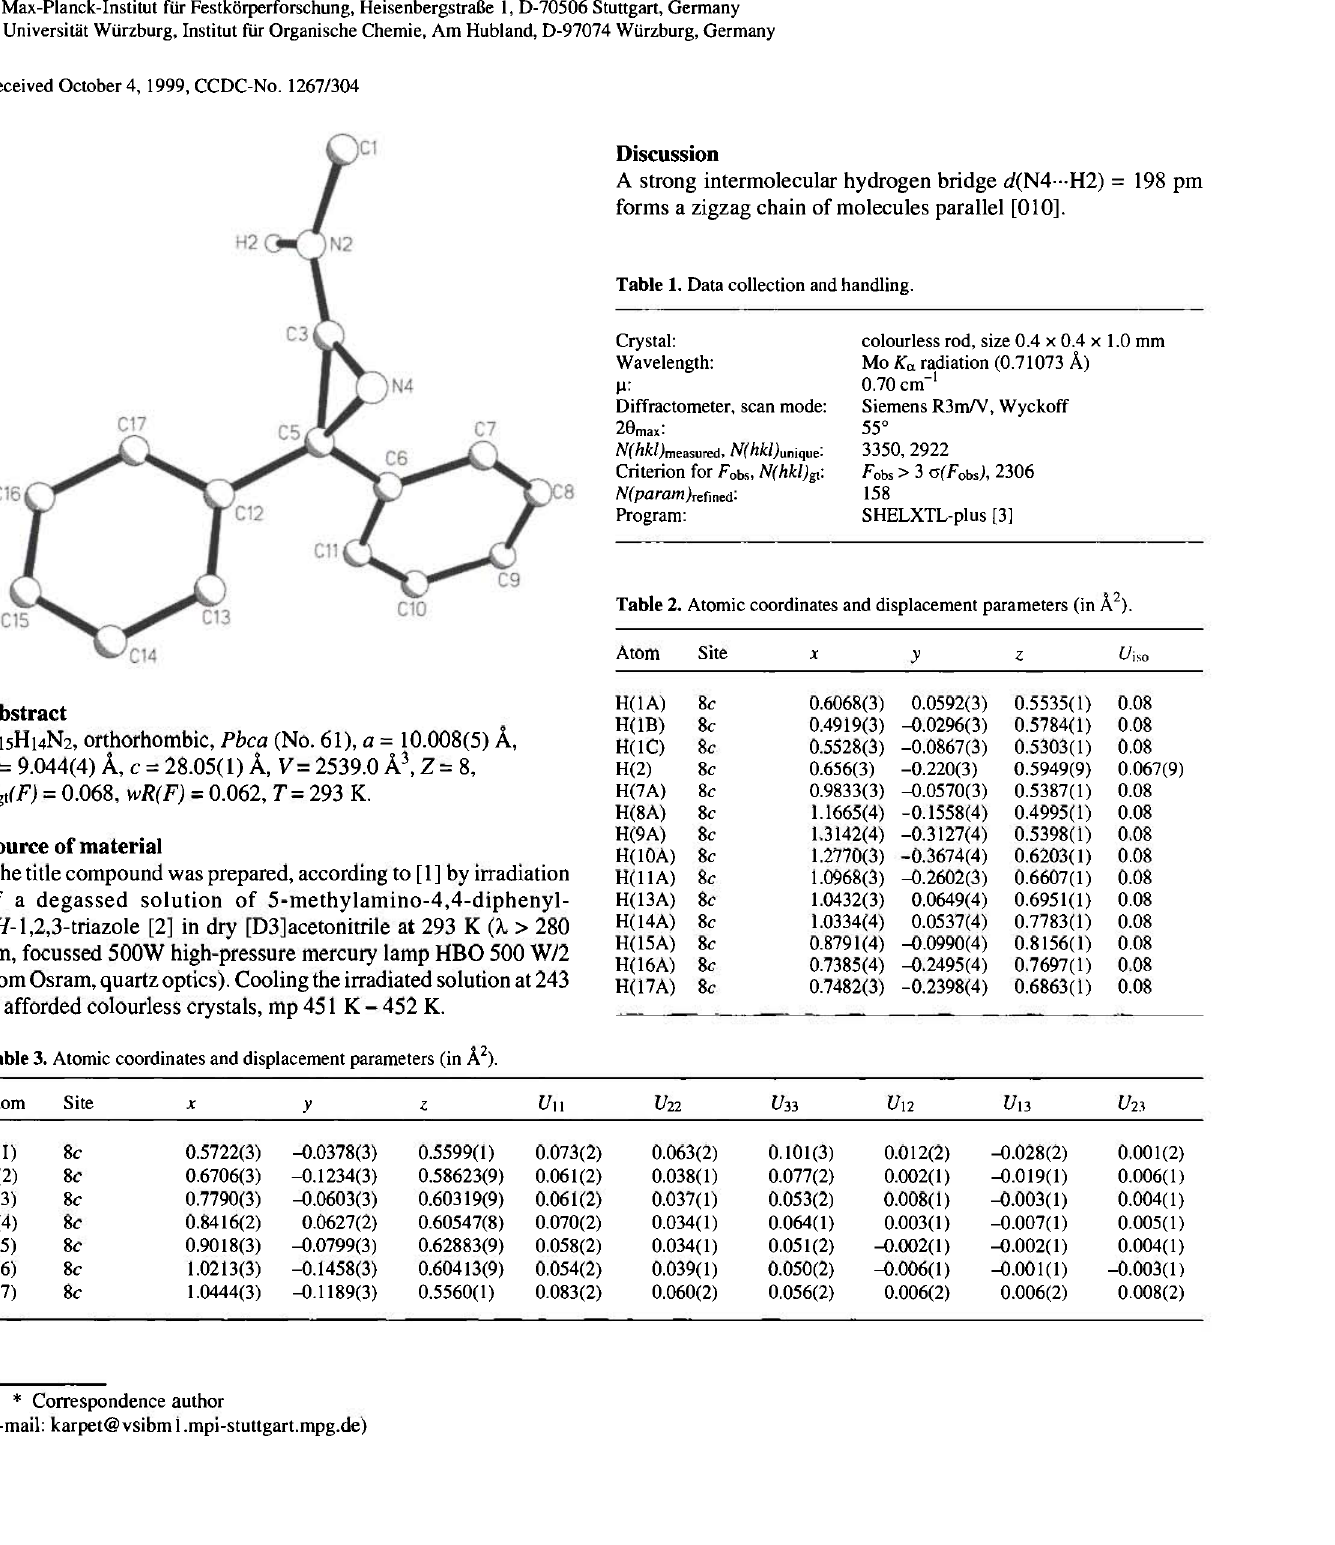
Table 2. Atomic coordinates and displacement parameters (in Ä 2 ).